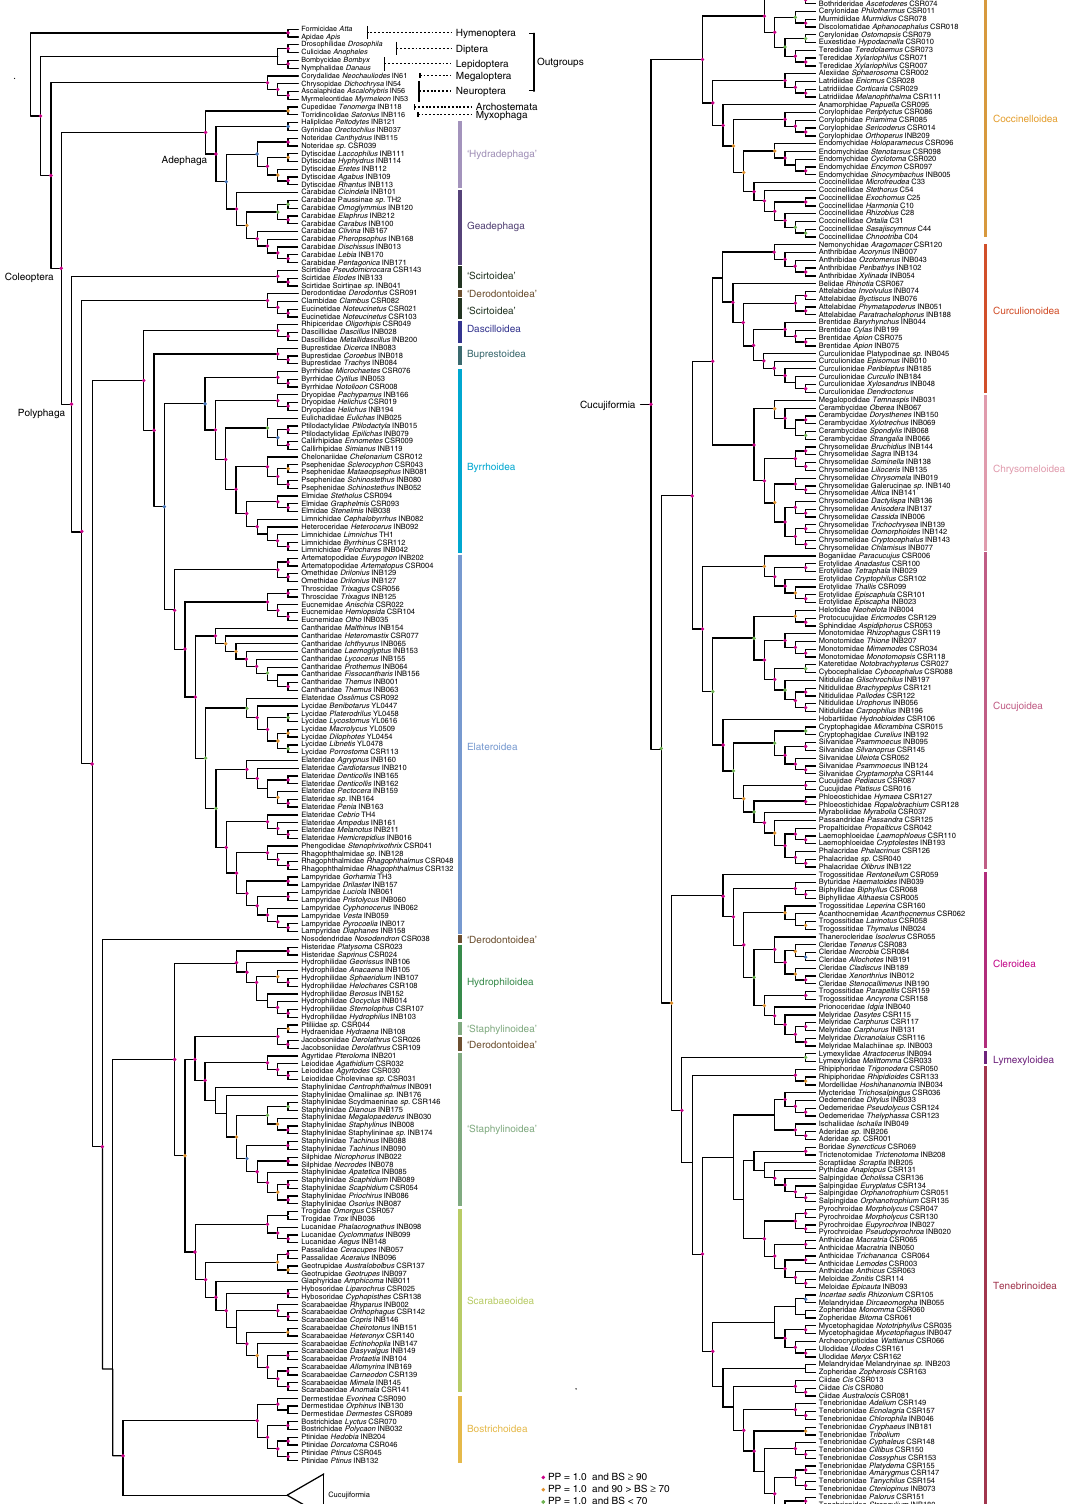
Fig. 2 Cladogram of Coleoptera. The topology was inferred from the concatenated amino acid data set by ML (RAxML) and Bayesian inference (Exabayes). Nodes with bootstrap values (BS) < 70 and posterior probabilities (PP) < 0.95 are not indicated by colored circles. Traditional taxonomic units that are not monophyletic are indicated with quotation